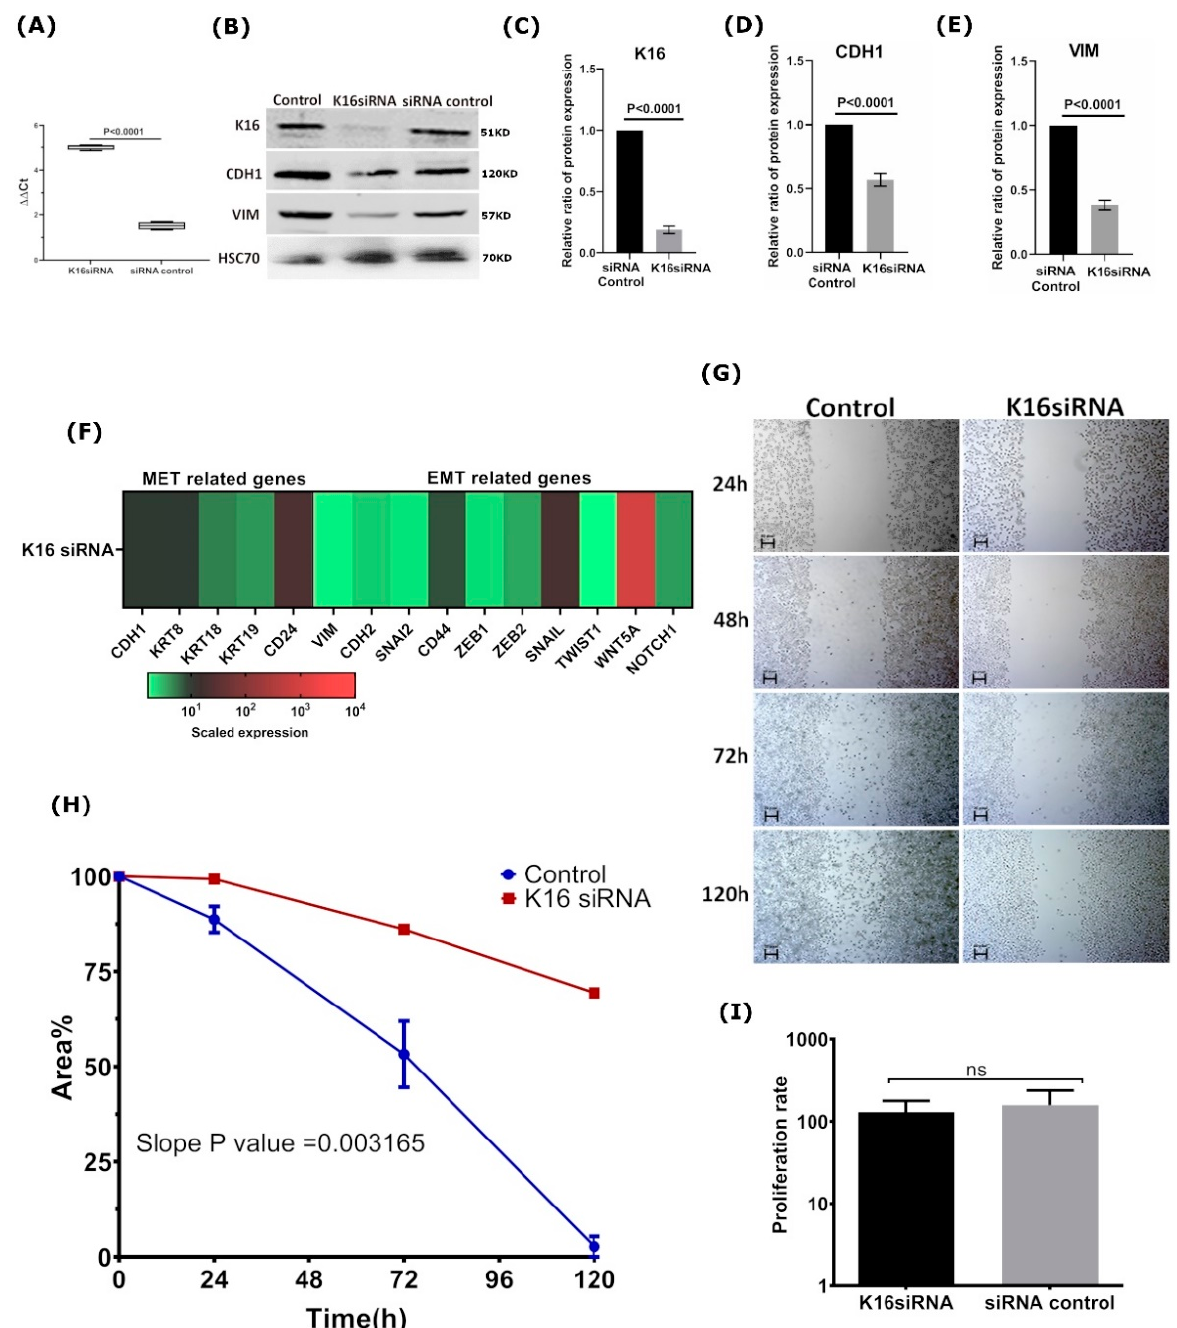
Figure 4. KRT16 knockdown in MDA-MB-468 impaired cell migration ( A ) mRNA expression level was verified after KRT16 knockdown compared to the non-target (siRNA control). ( B ) Immunoblot to verify the expression levels of CDH1 and VIM in KRT16 depleted cells. The relative ratio of protein expression of ( C ) K16; ( D ) CDH1; and ( E ) VIM. ( F ) Relative mRNA expression of EMT/MET-specific genes was investigated after KRT16 depletion; mRNA expression values were normalized to GAPDH and subsequently displayed relative to gene expression as a fold change 2^-( ∆∆ CT). ( G ) Microscopy images of migrated cells by wound-healing assay were performed on KRT16 depleted cells ( KRT16 siRNA) compared to control cells (siRNA control) at different time points of 0 h, 24 h, 72 h, and 120 h; n = 2, scale bar represents 100 µm. ( H ) In migration, linear regression analysis was performed for the velocity slope of KRT16 -siRNA transfected cells and untreated cells (control). ( I ) Cell proliferation rates of KRT16 -siRNA transfected and siRNA control cells were determined using Trypan Blue Dye, and the cells were counted by a Vi-CELL Counter device, the data are expressed as the mean ± SD.; n = 3. The p -values were calculated by the Wilcoxon rank-sum test ( p < 0.05).